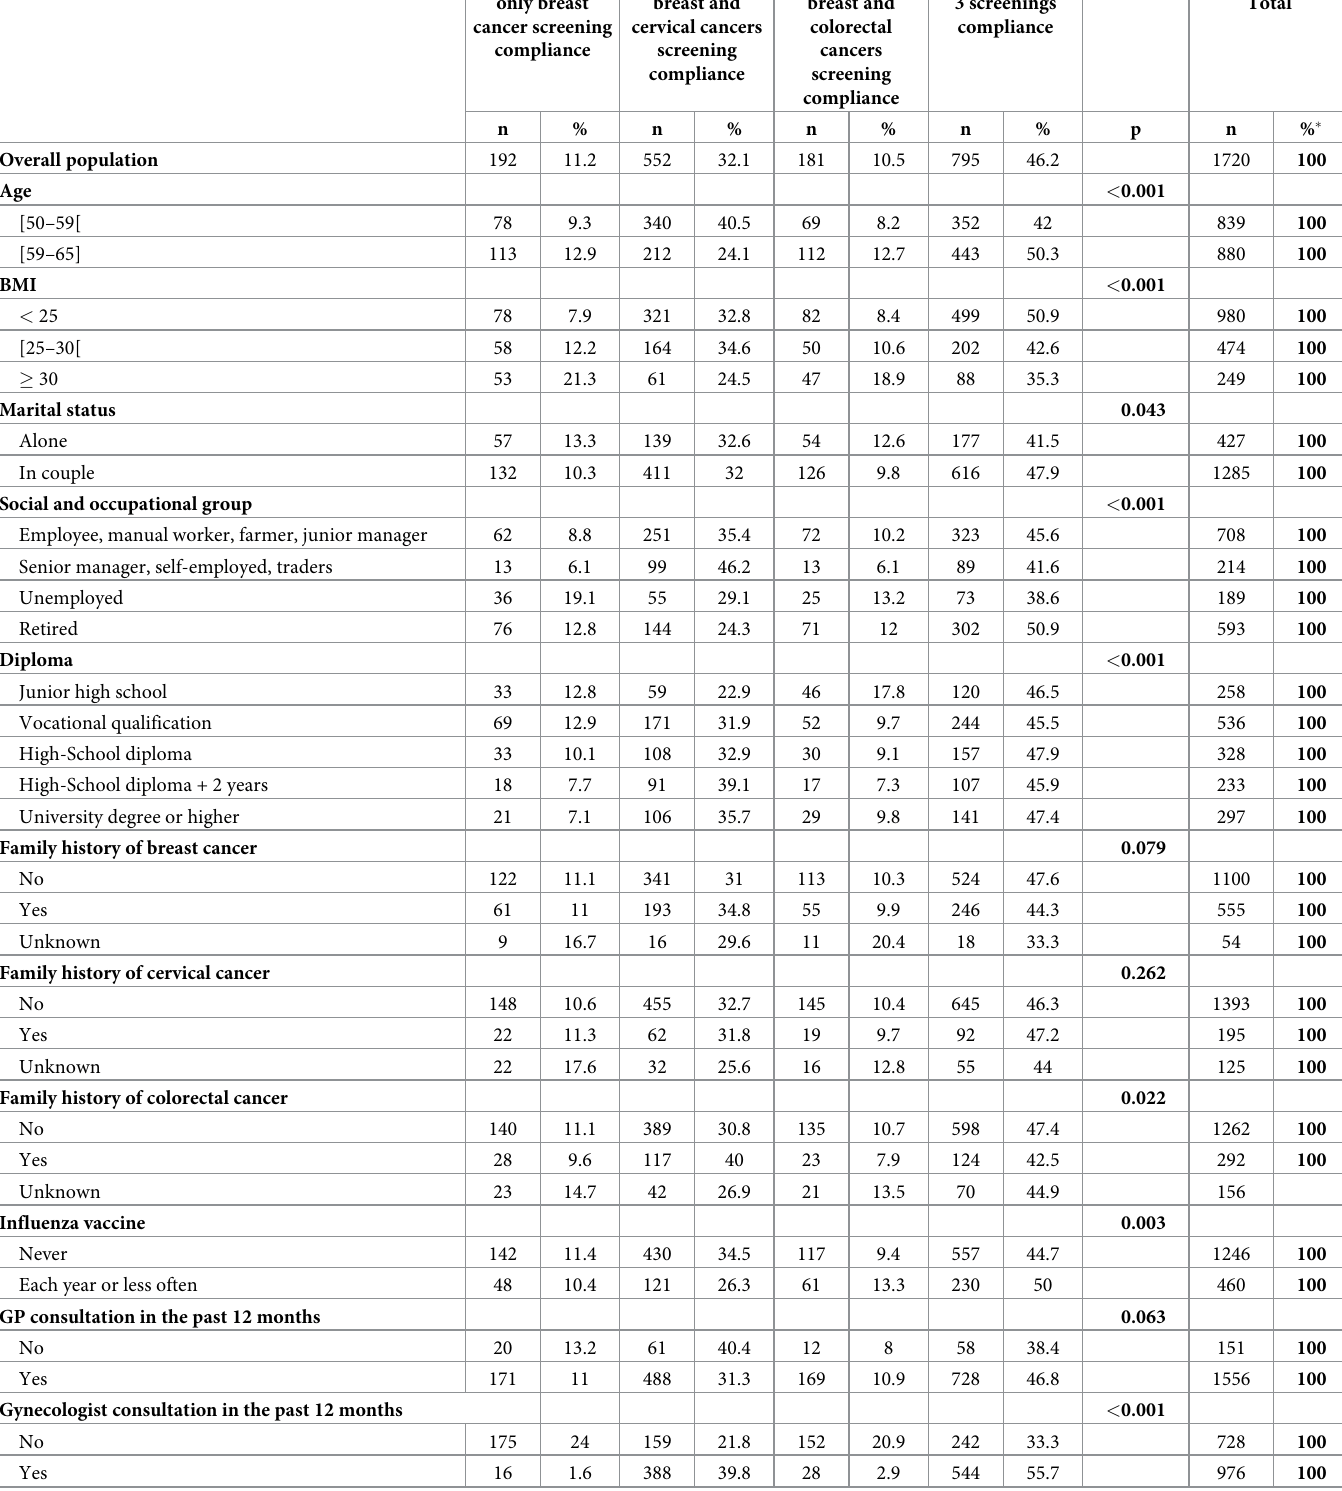
Table 3. Screening participation rates among women still up to date for organized breast